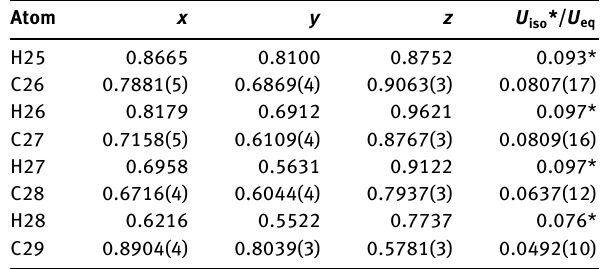
Table 2: Fractional atomic coordinates and isotropic or equivalent isotropic displacement parameters (Å 2